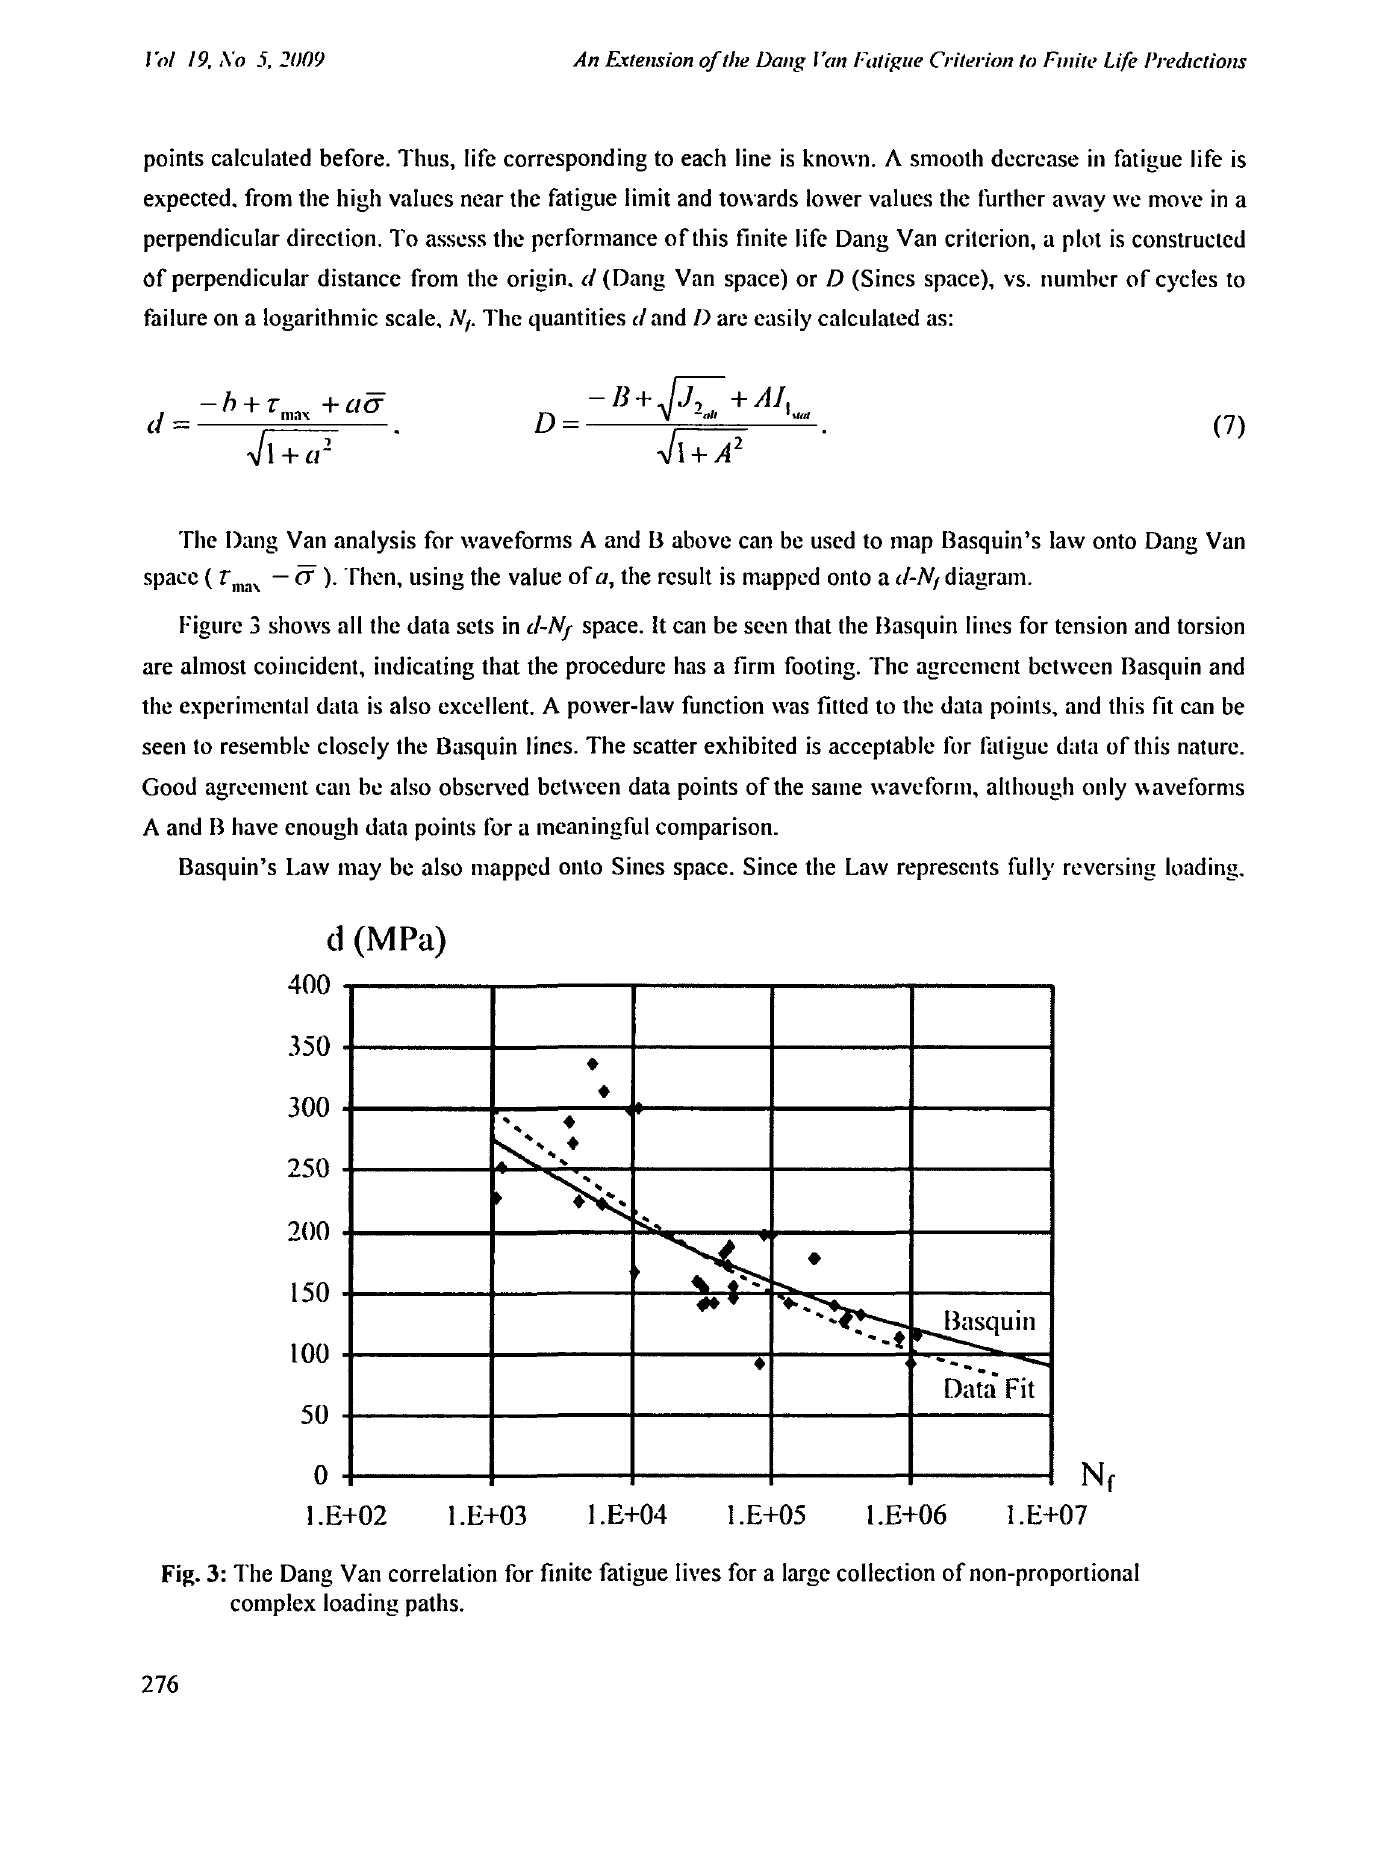
Fig. 3: The Dang Van correlation for finite fatigue lives for a large collection of non-proportional complex loading